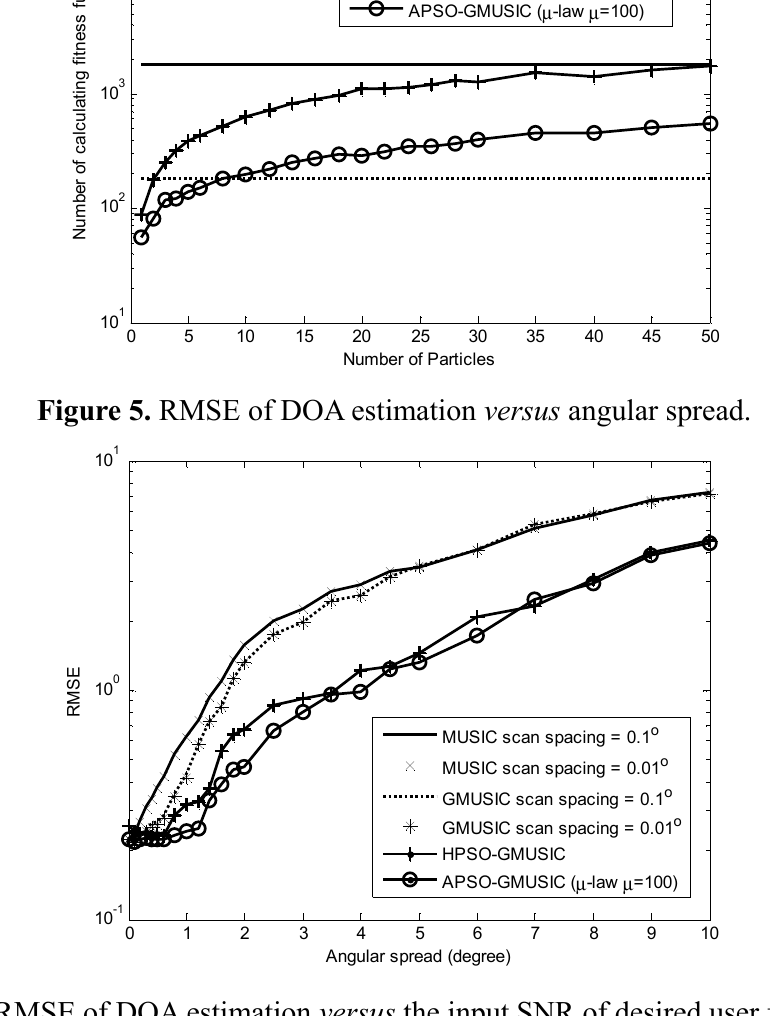
Figure 6. RMSE of DOA estimation versus the input SNR of desired user for 2 ∆